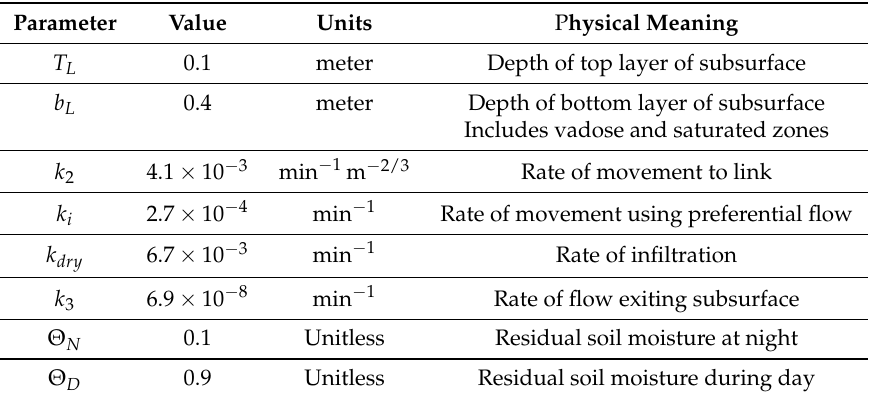
Table 3. Parameter values to be used for simulations of the system